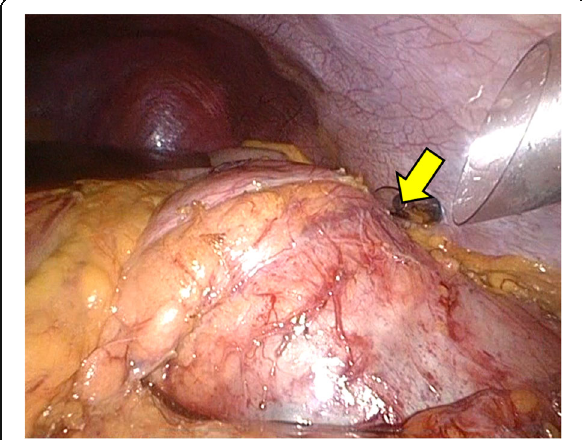
Fig. 4 A soft tumor was identified in the pancreatic tail